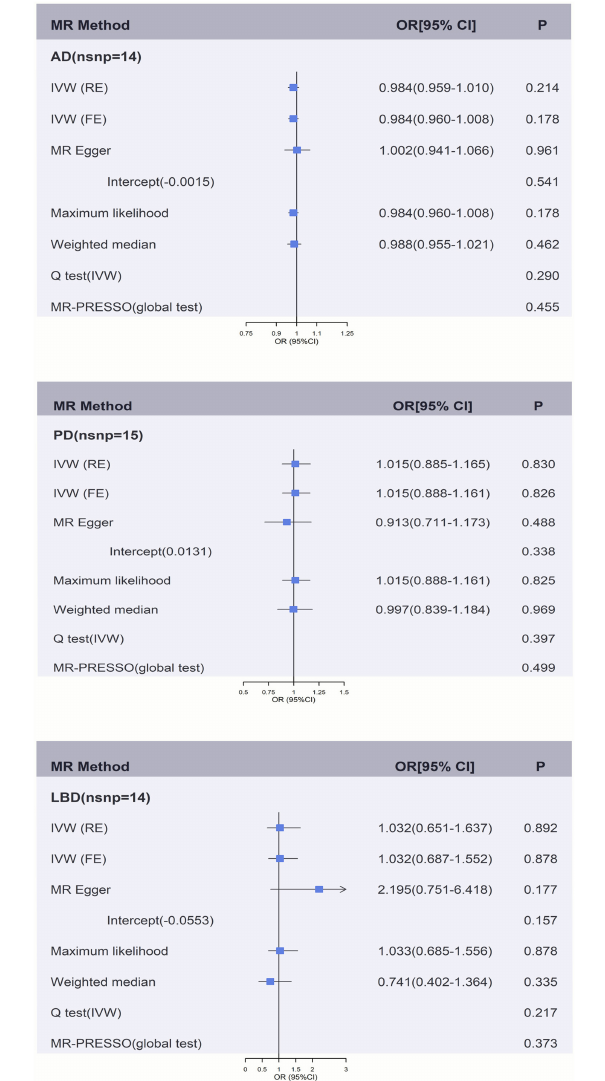
fixed effects OR = 0.912 (95%CI:0.581, 1.431), P = 0.688] [IVW γ fixed effects OR = 0.837 (95%CI:0.558, 1.256), P = 0.053]. In the results of the fixed effects IVW-based MVMR, the effect of fibrinogen on AD did not change substantially after adjustment for height [fixed effects OR = 1.024 (95%CI:1.0005,